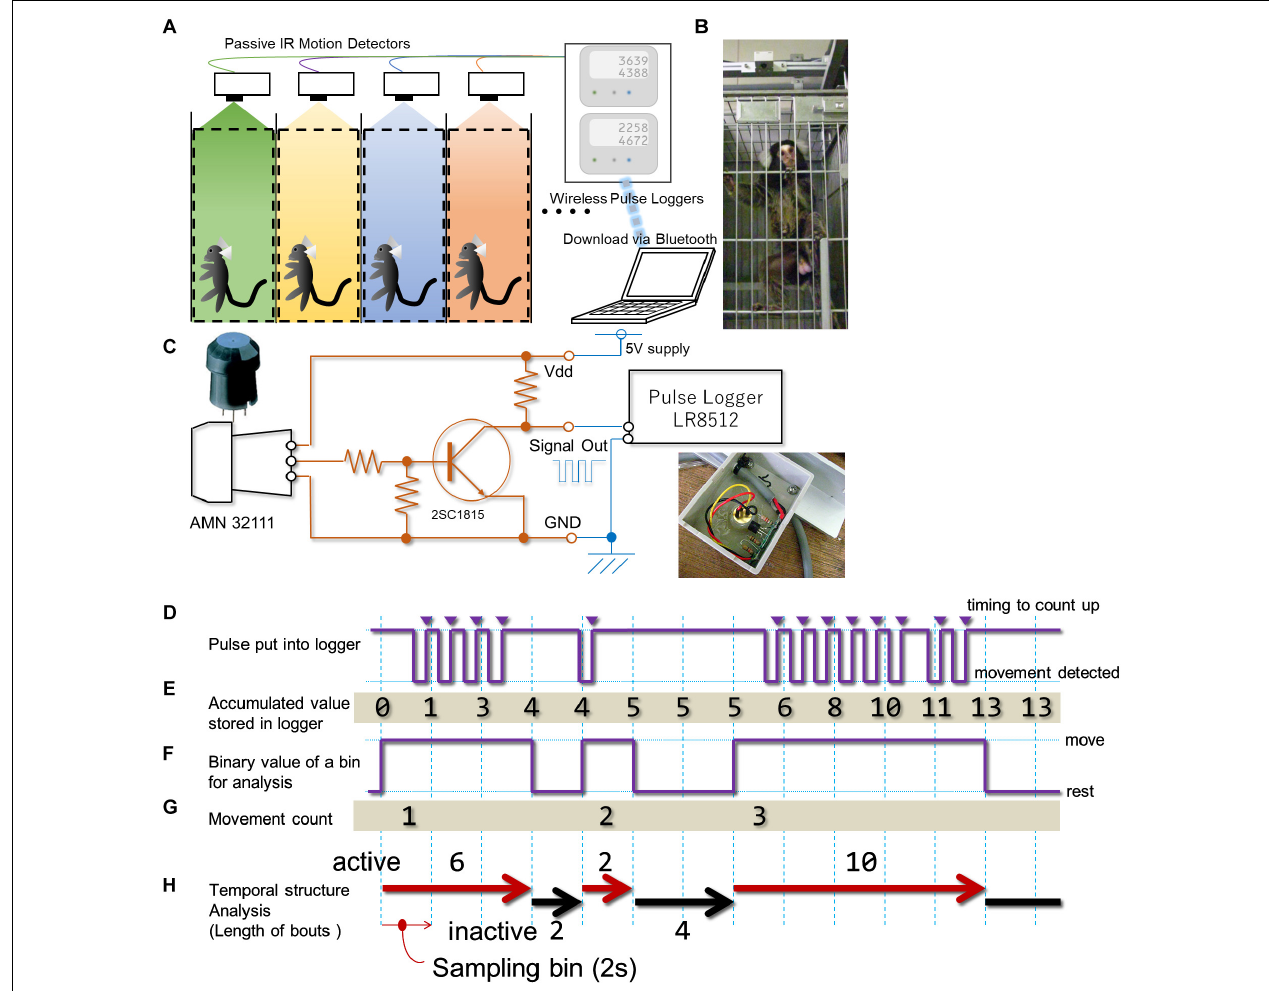
FIGURE 1 | In-cage continuous motility monitoring system for marmosets. (A) A schematic diagram of the in-cage continuous motility monitoring system for marmosets. A passive infra-red pyroelectric motion sensor was attached above the ceiling of each cage. Signal from four animals were concurrently and continuously stored by two data loggers, which was downloaded once a week by a PC via blue tooth interface. (B) Photo image of the motion sensor (top) and marmoset. (C) A circuit diagram of the custom-made buffer amplifier inserted between each motion sensor and data logger. Inset, a photo image of actual installation of the circuit board. (D) The sensor sends a negative logic pulse when a movement is detected. This example shows movements of a single marmoset detected during a 28-s period by the sensor. (E) The logger counts pulses at each occasion when the logic signal level reaches a high voltage level (triangles) and adds the counts in an incrementally accumulating manner at every 2-s intervals (sampling bin). For the period presented in this example, 13 pulses were detected and accumulated. (F-H) Offline processing of the accumulated value from the data logger. (F) We converted the accumulated value retrieved from the data logger into a series of binary queue so that it could represent whether or not the increase in the accumulated value occurred every 2 s. (G) With our definition of movement, three movements were detected. (H) From the binary queue of movement (F) , we computed indexes for the successiveness of each phase (active and inactive phases, length of movement bout, length of the inactive phase). See methodology for